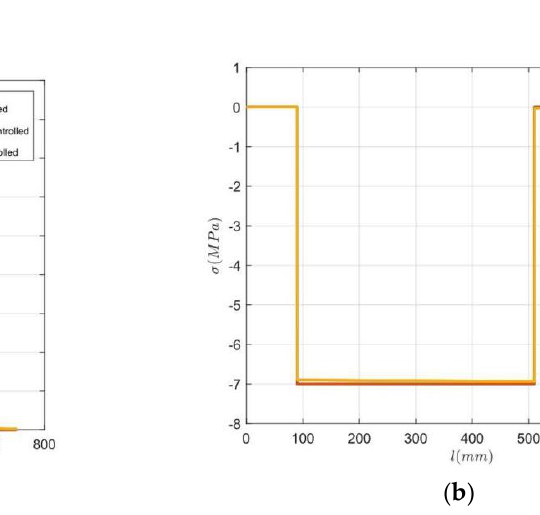
Figure 8. ( a ) Trajectories for desired curvature (in blue) actual curvature without controller (in red) and with a PI-controller (in yellow). ( b ) Trajectories for desired residual stresses coinciding with the actual residual stresses without controller (in red). Actual residual stresses with a PI-controller (in yellow).